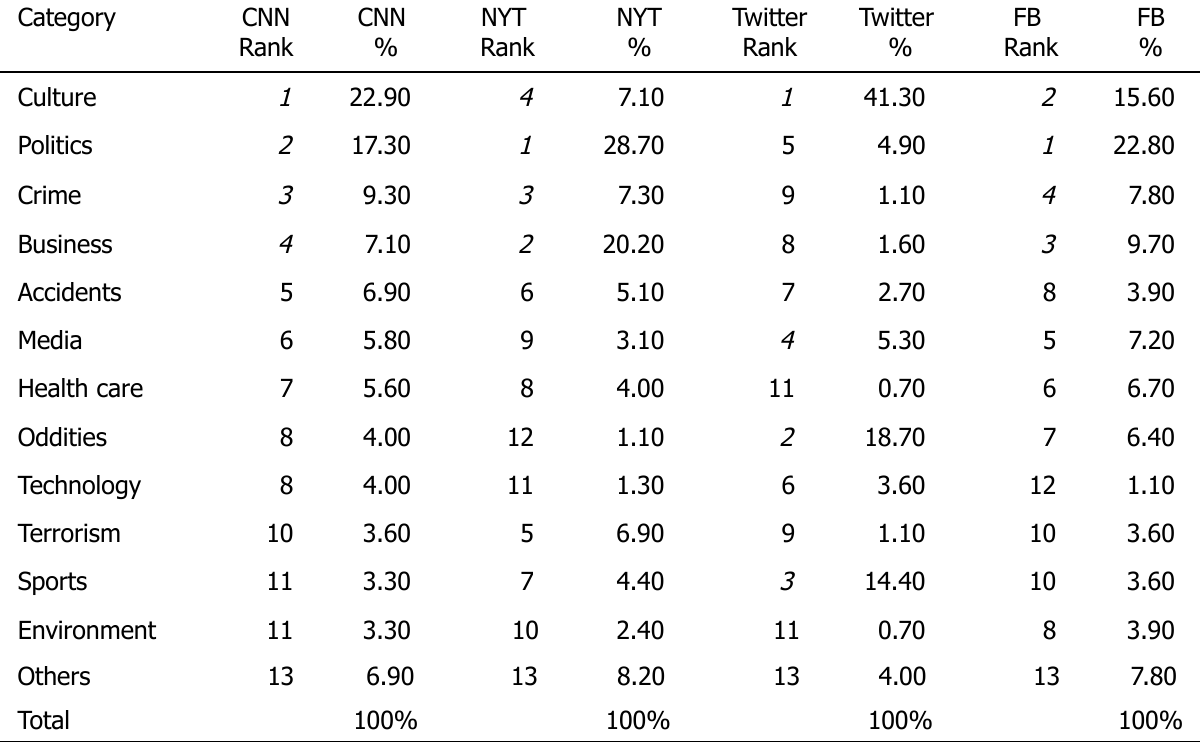
Table 1. Issue salience by topical category in coverage on CNN, New York Times, Twitter and Facebook.